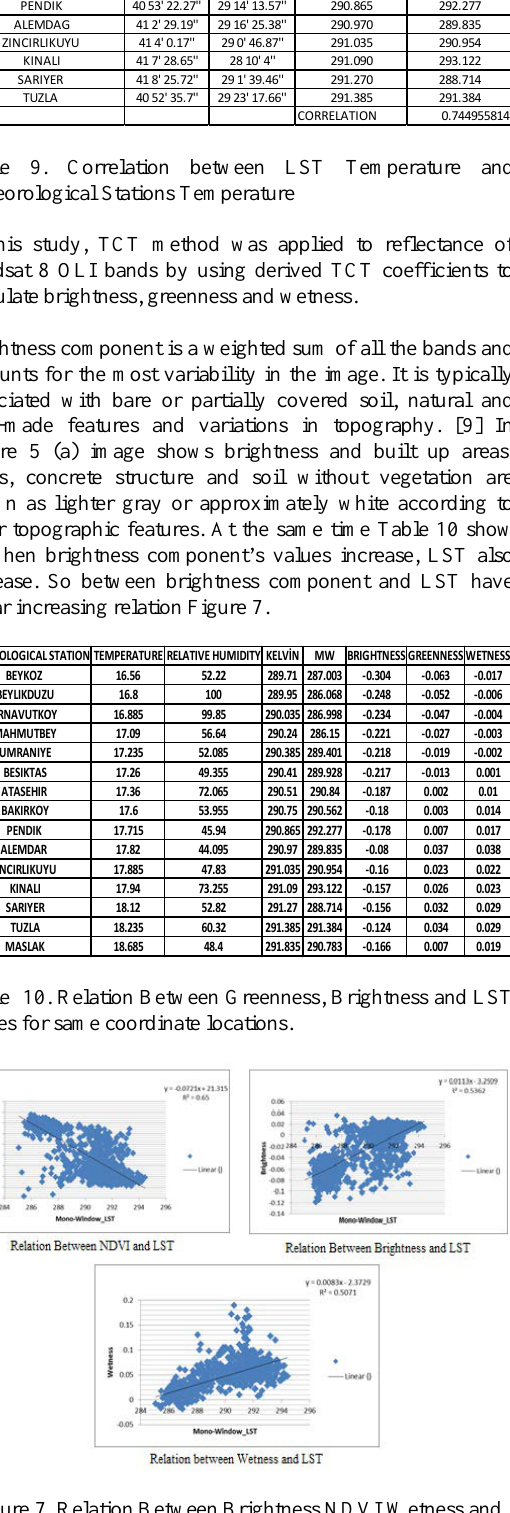
Figure 7. Relation Between Brightness,NDVI,Wetness and